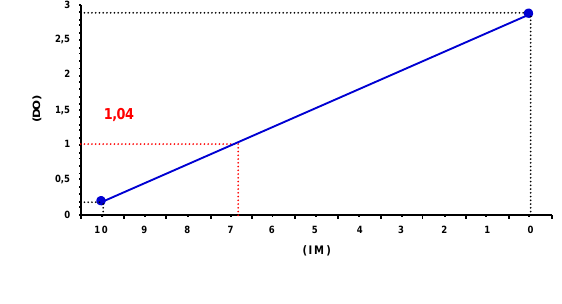
FIGURA 1 - Exemplo do cálculo do Índice de Mineralização